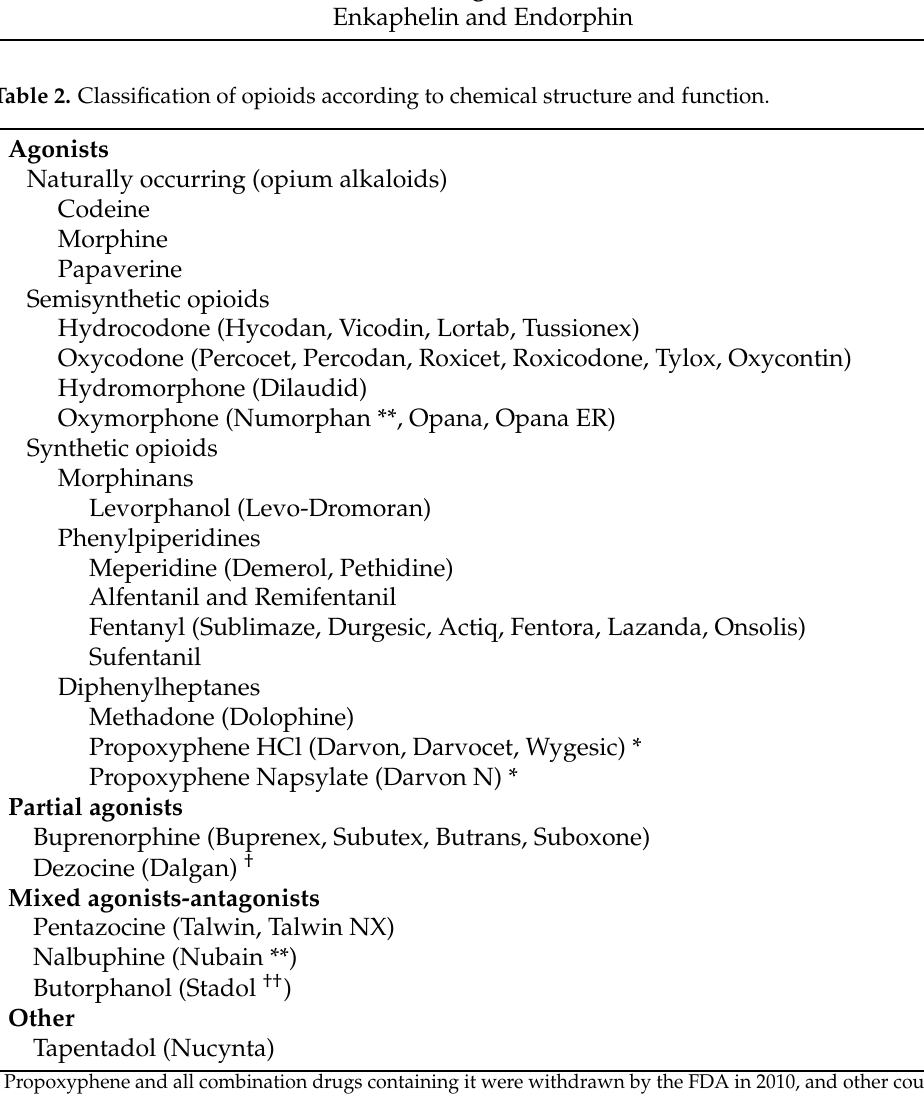
Table 2. Classification of opioids according to chemical structure and